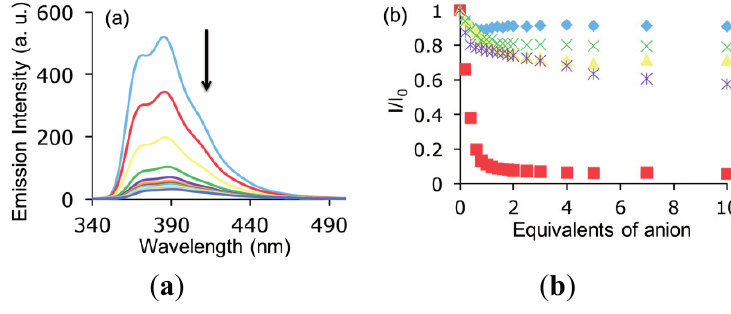
Figure 4. ( a ) Evolution of emission spectra upon addition of benzoate in acetonitrile, [ 1 ] = 2 × 10 − 5 M. ( b ) Titration isotherms:  benzoate,  acetate, ▲ fluoride,  dihydrogenphosphate and  hydrogenpyrophosphate.